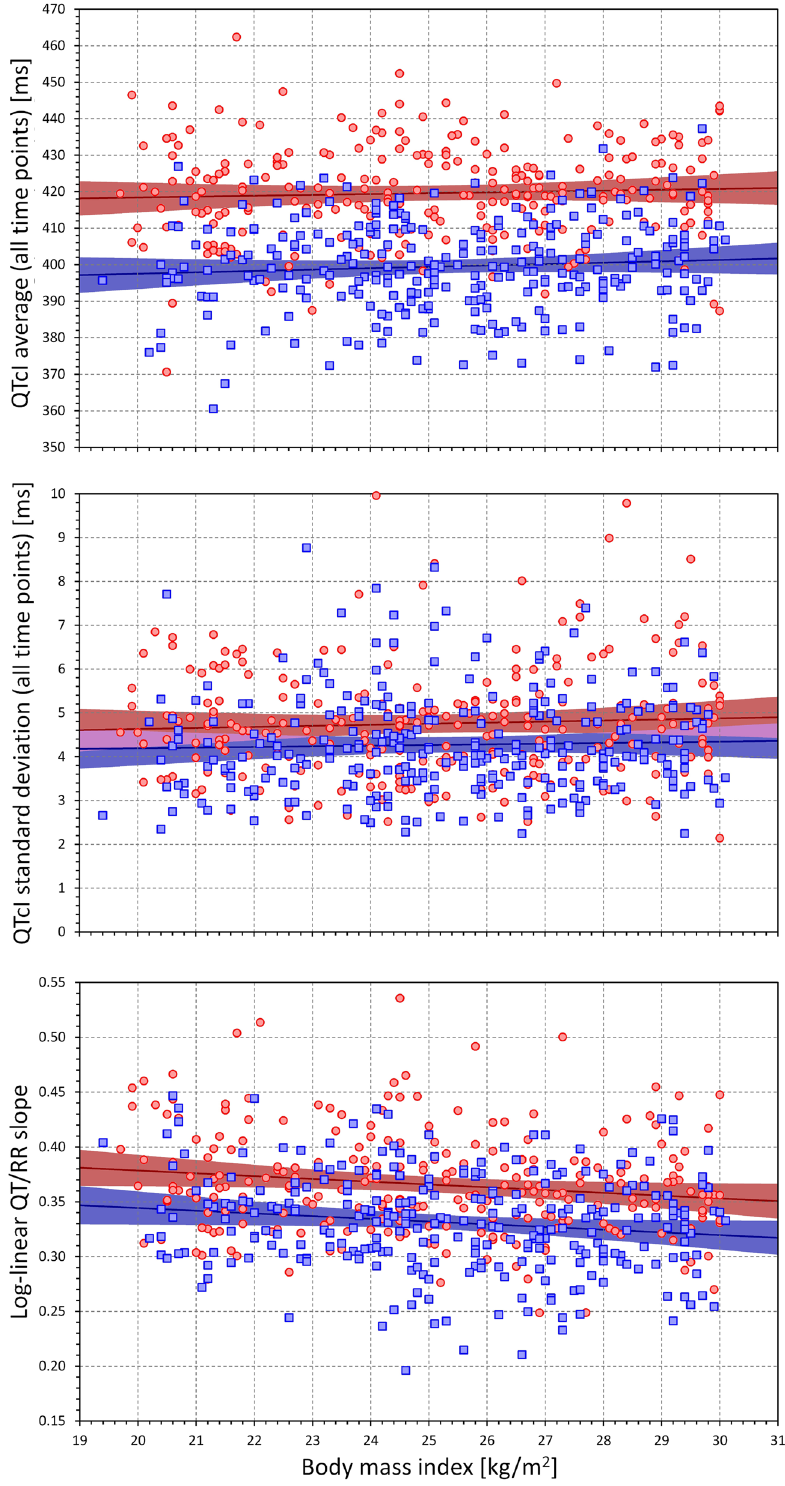
Figure 4. Scatter diagrams between the body mass index and mean QTcI values of all ECG measurements in all study time-points (top panel), standard deviation of QTcI values of all ECG measurements in all study time- points (middle panel), and subject-specific log-linear QT/RR slope (bottom panel). The meaning of symbols and Figure layout is the same as in Fig. 3. kg kilograms, m metre, ms